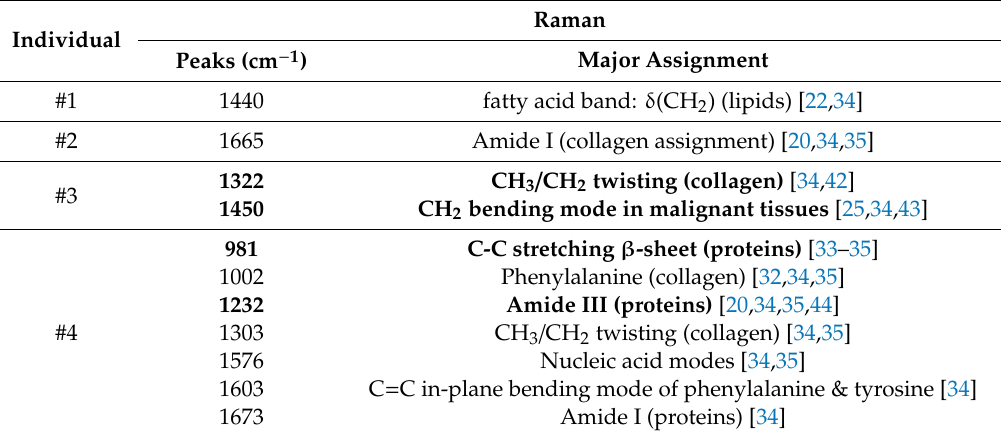
Table 9. Di ff erentiating peaks in the analyzed